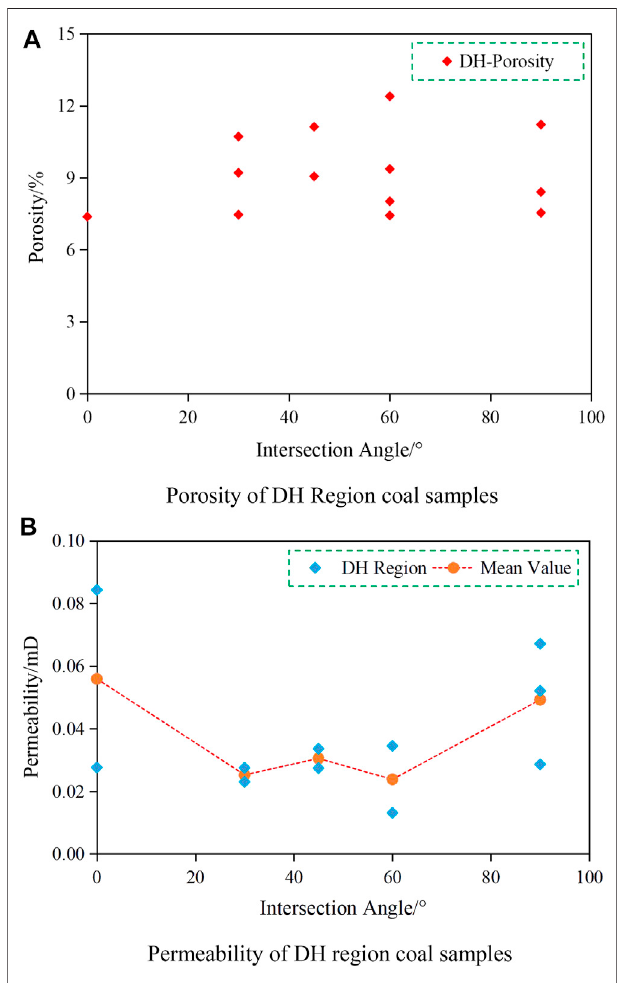
FIGURE 4 | Relationship between permeability and Intersection angle of coal in DH region. (A) Porosity of DH Region coal samples. (B) Permeability of DH region coal samples.